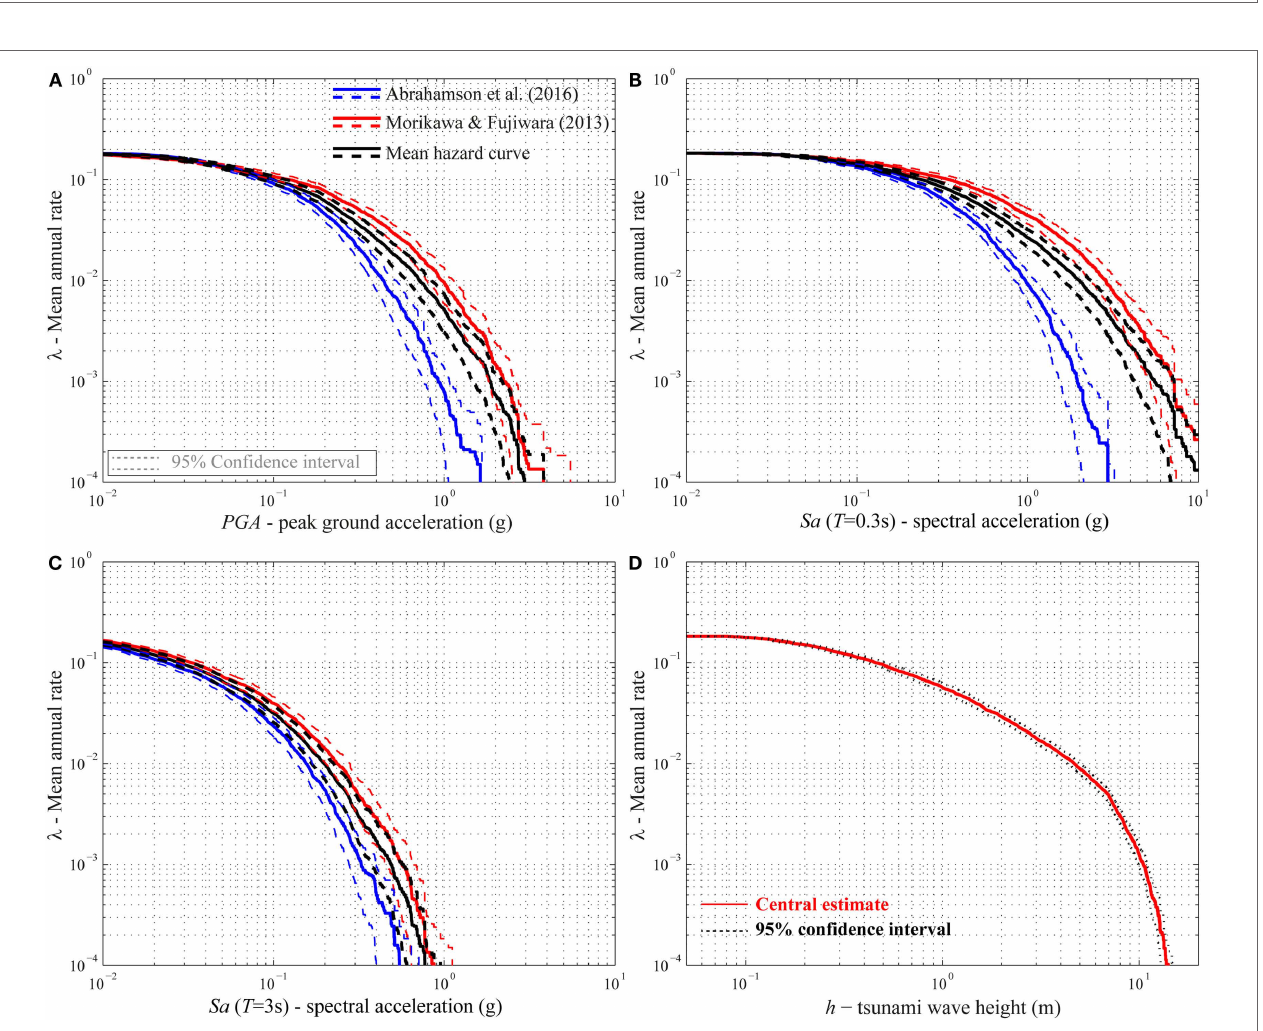
FIGURE 12 | (A) Final seismic hazard curves for PGA. (B) Final seismic hazard curves for S a ( T = 0.3s). (C) Final seismic hazard curves for S a ( T = 3s). (D) Final tsunami hazard curves.